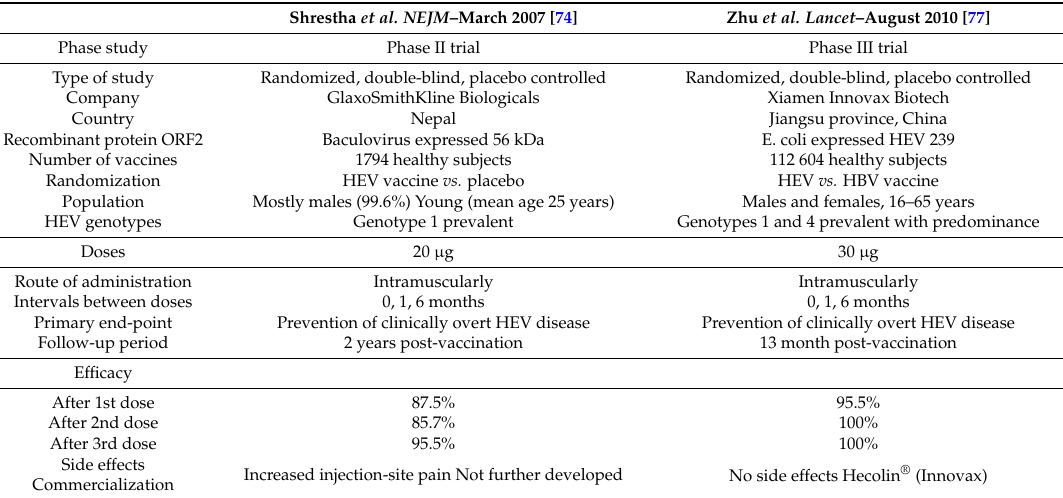
Figure 6. Hepatitis E viral genome [76]. This image was used with permission from the publisher. Table 4. Clinical trials of HEV vaccine [69]. This figure was used with permission from the publisher. Shrestha et al. NEJM –March 2007 [74] Zhu et al. Lancet –August 2010